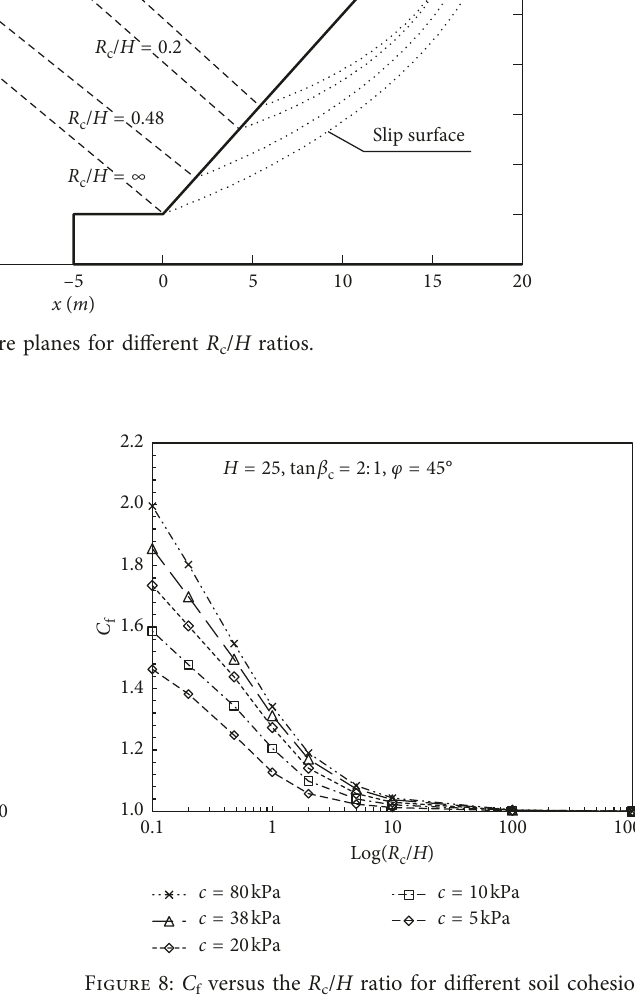
f versus the R c / H ratio for different soil